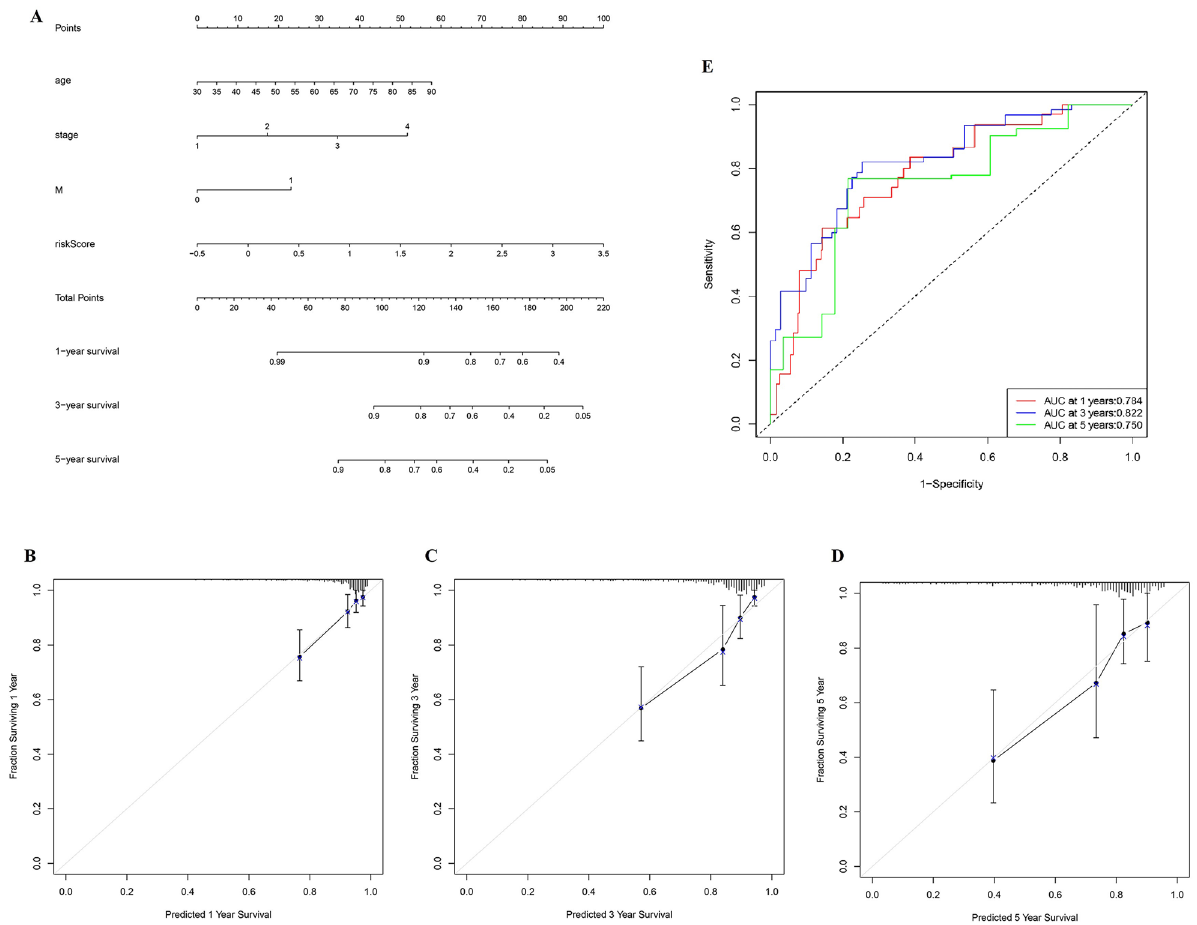
Figure 8. Construction of a nomogram. ( A ) A nomogram model was constructed. ( B )–( D ) Calibration plots showed the nomogram model had a similar performance when compared to ideal model. ( E ) ROC curves predict the predictive ability of our